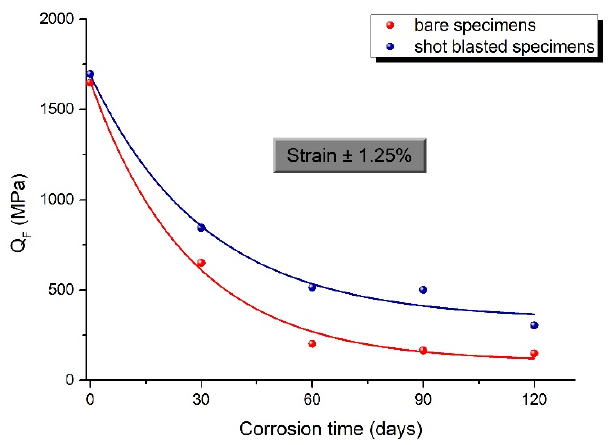
Figure 12. Extracted fitting curves of fatigue damage indicator Q F as a function of corrosion expo- sure for imposed deformation ±1.25% for both groups of specimens. for imposed deformation ± 1.25% for both groups of